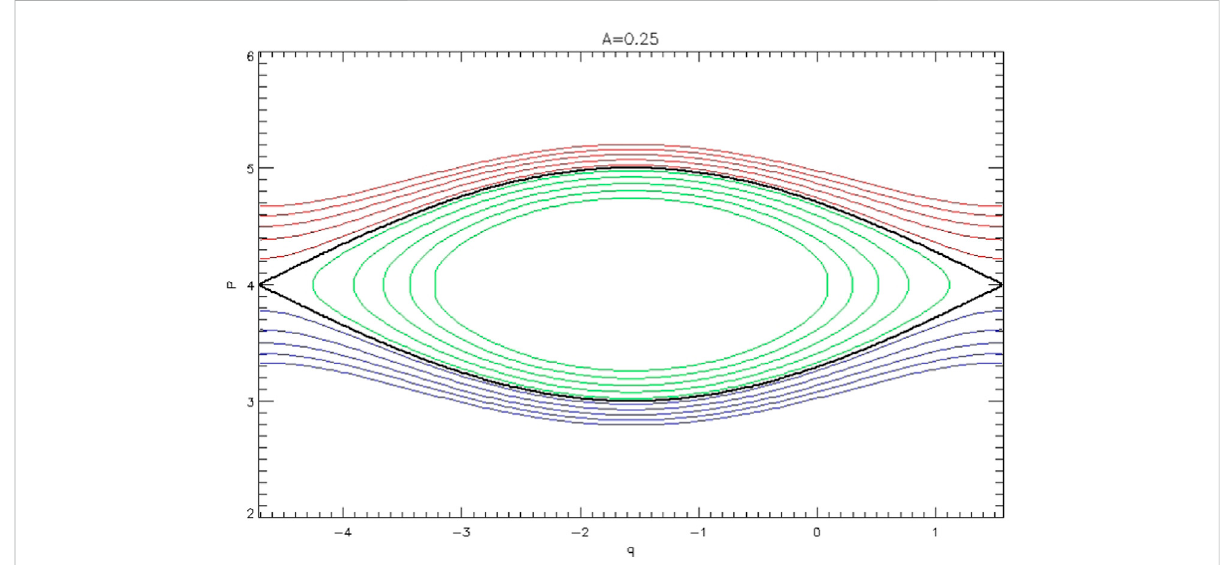
FIGURE 3 Contours of the pendulum Hamiltonian H ( P , q ) given by Eq. 10, with A = 0.25. If the inhomogeneity parameter R is small but positive, the separatrix (shown in black) slowly rises. At resonance near the X -point, particles cross from red contours to blue (phase bunching) or green (phase trapping)